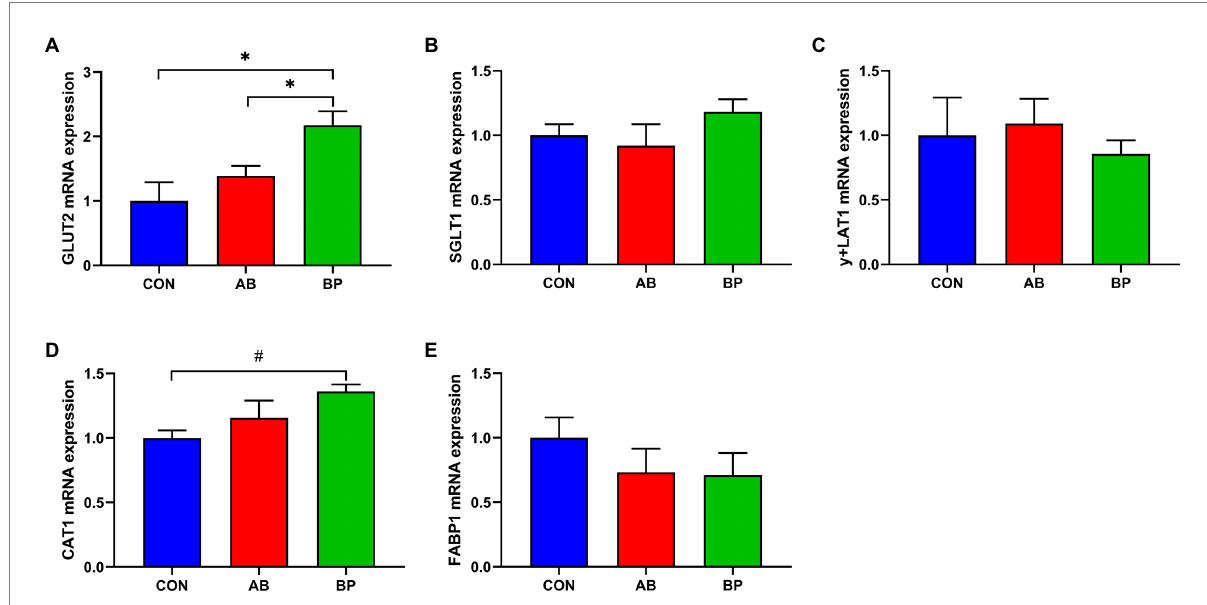
FIGURE 7 Effects of dietary supplemented with Bopu powder on expressions of nutrient transport genes in intestine of broiler chickens. (A) Glucose transporter type 2 ( GLUT2 ); (B) Sodium-glucose transporter 1 ( SGLT1 ); (C) y + L amino acid transporter-1 ( y + LAT1 ); (D) Cationic amino acid transporter-1 ( CAT1 ); and (E) Fatty acid binding protein-1 ( FABP1 ). CON group, broiler chickens fed a basal diet; AB group, broiler chickens fed a basal diet supplemented with 50 mg/kg aureomycin; BP group, broiler chickens fed a basal diet supplemented with 40 mg/kg Bopu powder containing protopine and allocryptopine. Values are mean ± standard error ( n = 6). # 0.05 ≤ p < 0.10, * p < 0.05.